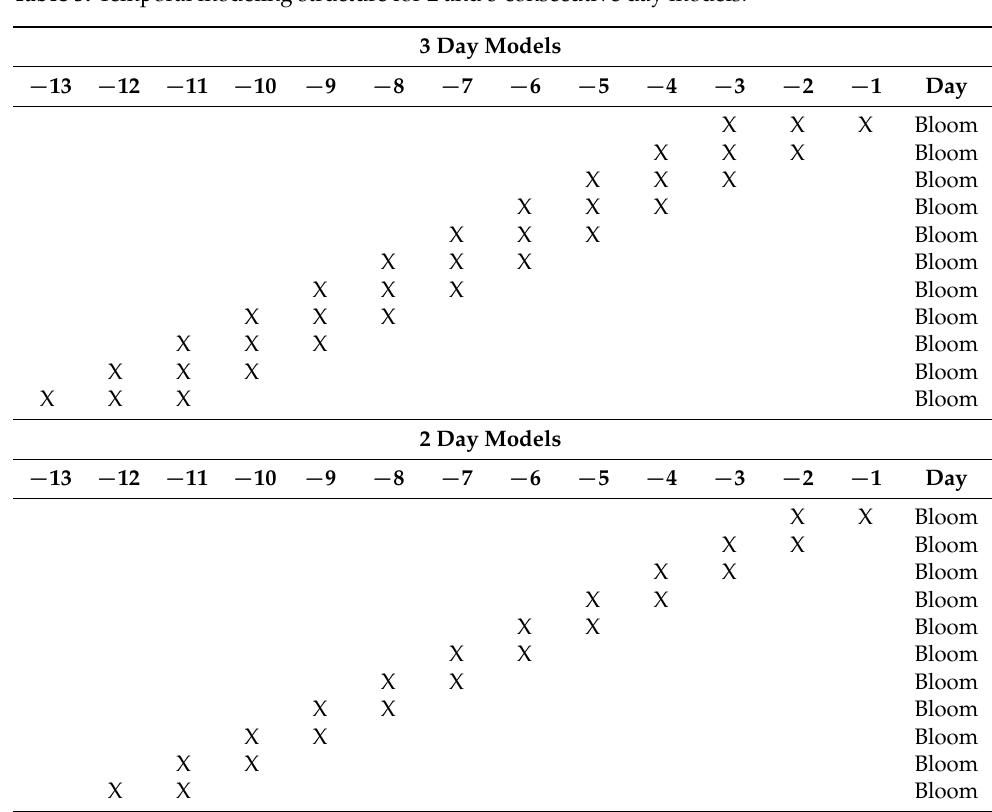
Table 3. Temporal modeling structure for 2 and 3 consecutive day models.